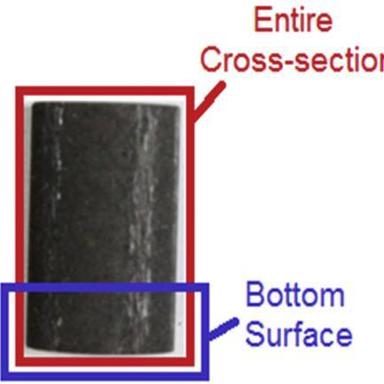
Locations analysed by SEM for the fracture arising from the compressive tests.